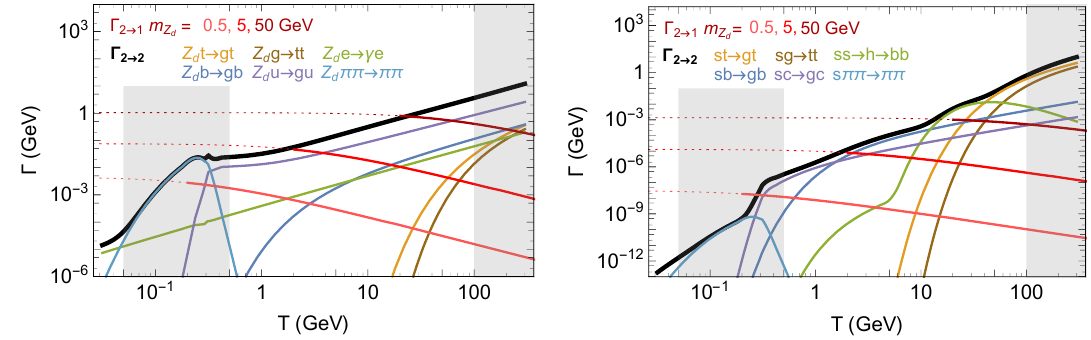
Figure 1 . Rates for 2 $ 2 (in black) vs. 2 $ 1 transitions (in di(cid:11)erent shades of red depending on the mediator mass) as a function of the temperature. Dotted lines correspond to the 2 $ 1 rates after the mediator becomes non-relativistic, T < m= 2 : 46, with m the mediator mass. The gray region at low temperatures corresponds to the uncertain regions near (cid:3) QCD (cid:17) 300 MeV, above which (cid:11) s becomes large, and the leading order calculation is unreliable, and below which 3 $ 2 pion processes (included in the 2 $ 2 rate, shown in light blue) dominate the equilibration. The gray region at high temperature is near the electroweak phase transition T c = 160 GeV; see appendix A for more details. Left: HSFO-VP. In this model the 2 $ 2 scattering rate is nearly linear with temperature above the chiral phase transition. After pion processes become ine(cid:11)ective and QED processes dominate, the scaling is nearly linear again. Right: HSFO-SP. In this model the 2 $ 2 rate is more sensitive to mass thresholds. It drops sharply after the chiral phase transition (kaon processes have been